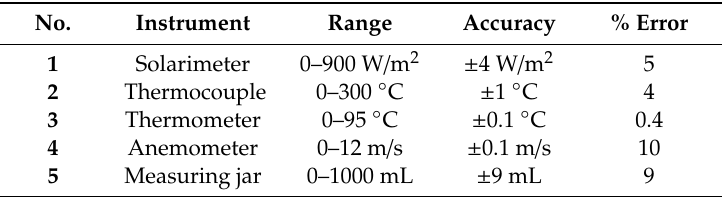
Table 4. The accuracies of various measurement instruments [42]. Table is reprinted with permission from publisher.